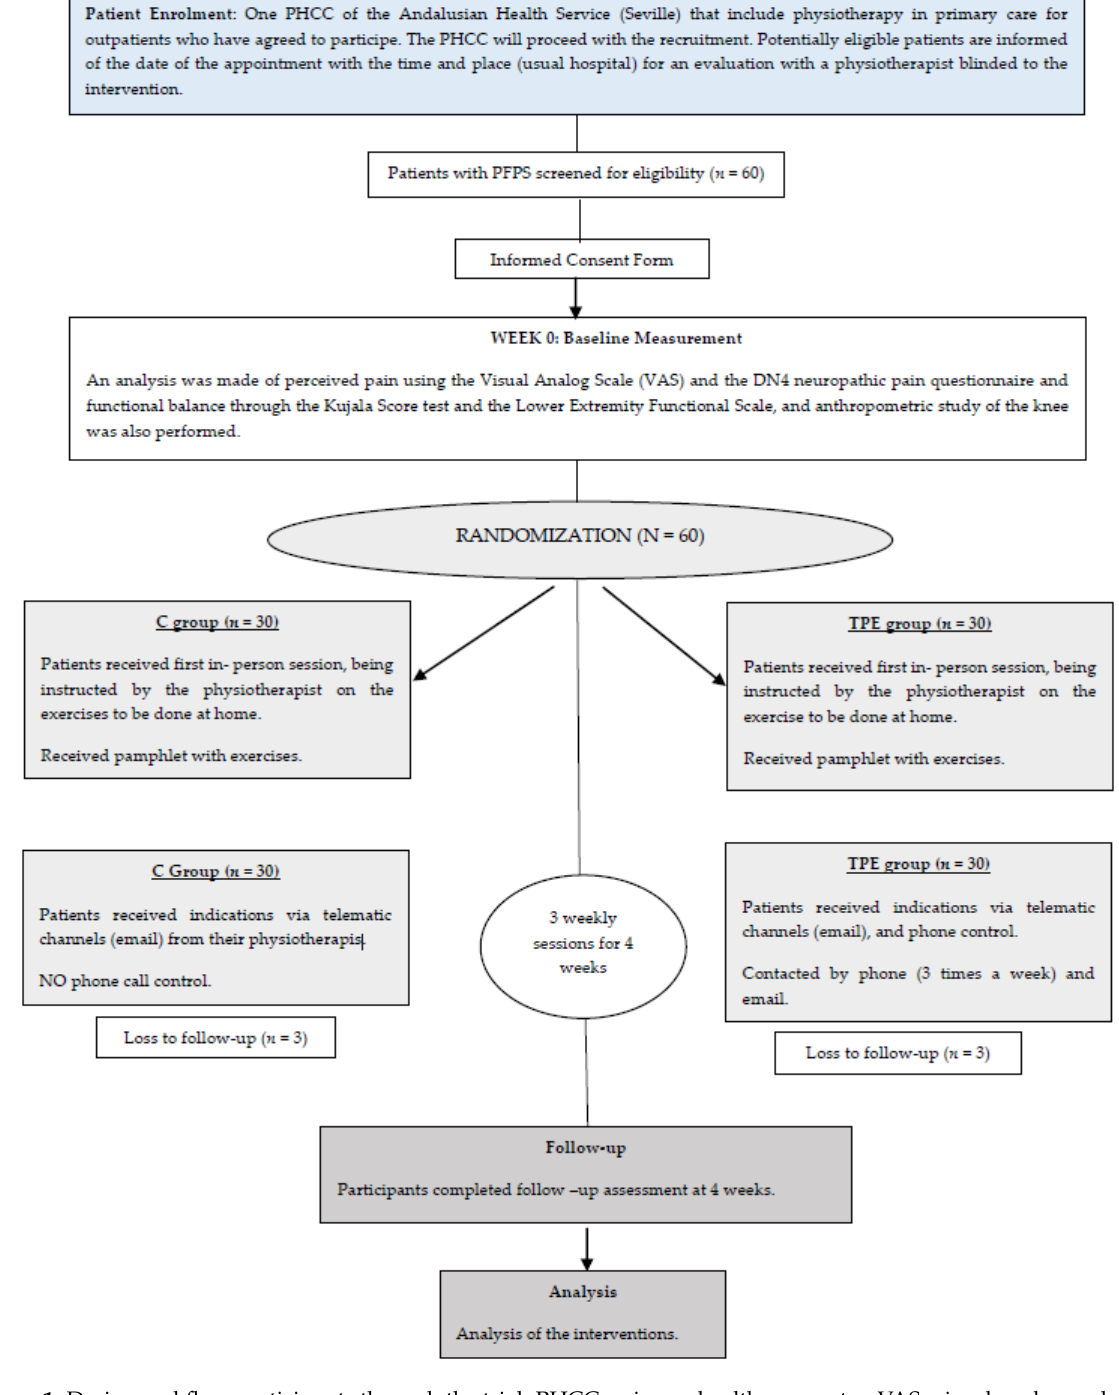
Figure 1. Design and flow participants through the trial. PHCC, primary healthcare centre; VAS, visual analog scale; TPE, therapeutic physical exercise group.